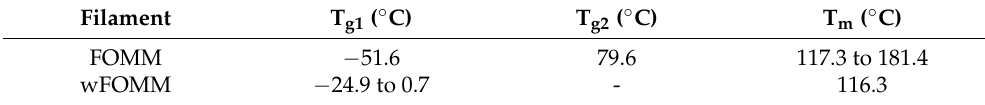
Figure 8. DSC of printed FOMM and wFOMM specimens. Table 4. Transition temperatures of the FOMM printed specimens obtained by DSC.